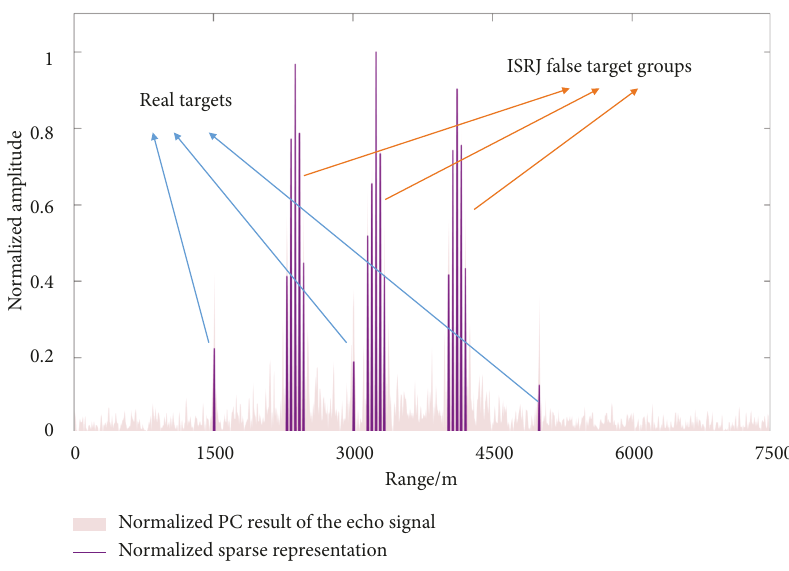
Figure 10: Spare representation of the echo